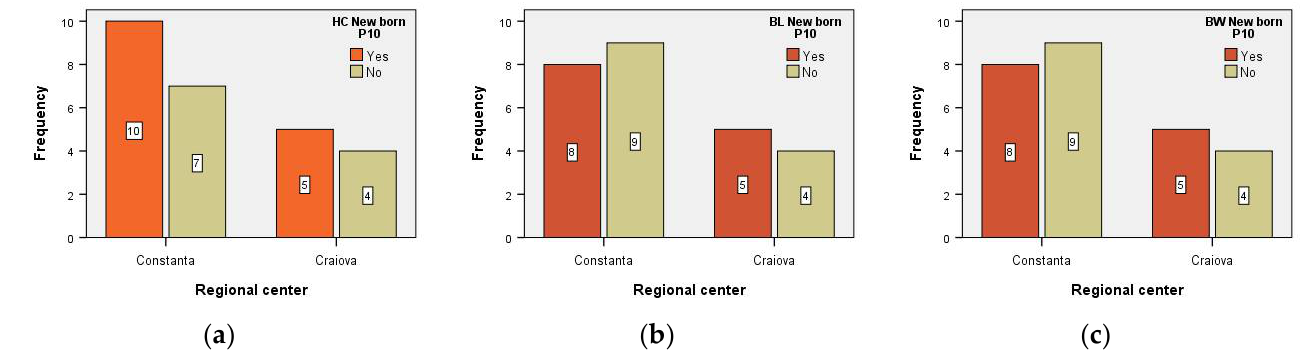
Figure 2. Anthropometric parameters ( a ) head circumference (HC), ( b ) birth length (BL), and ( c ) birth weight (BW) of HIV-positive newborns from the two Regional Centers. P10 = percentile 10